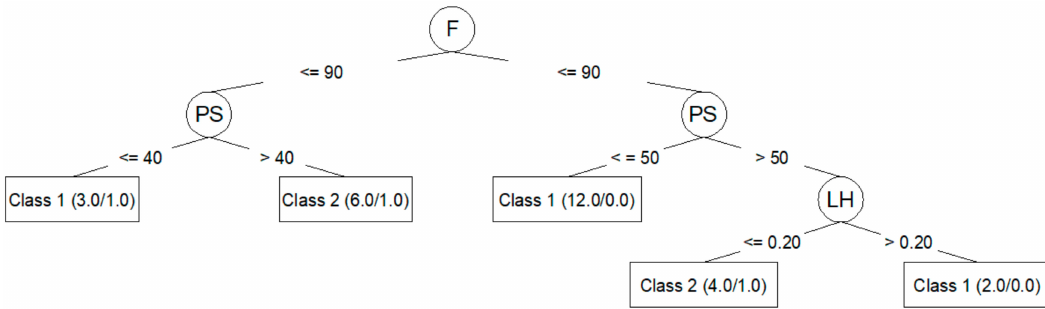
Figure 3. J48 (C4.5) decision tree for R a ,0 .